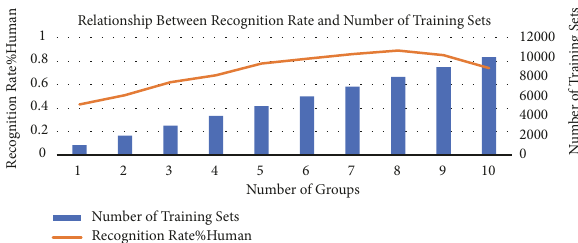
Figure 9: Relationship between target detection, recognition rate, and training set data in a marine platform